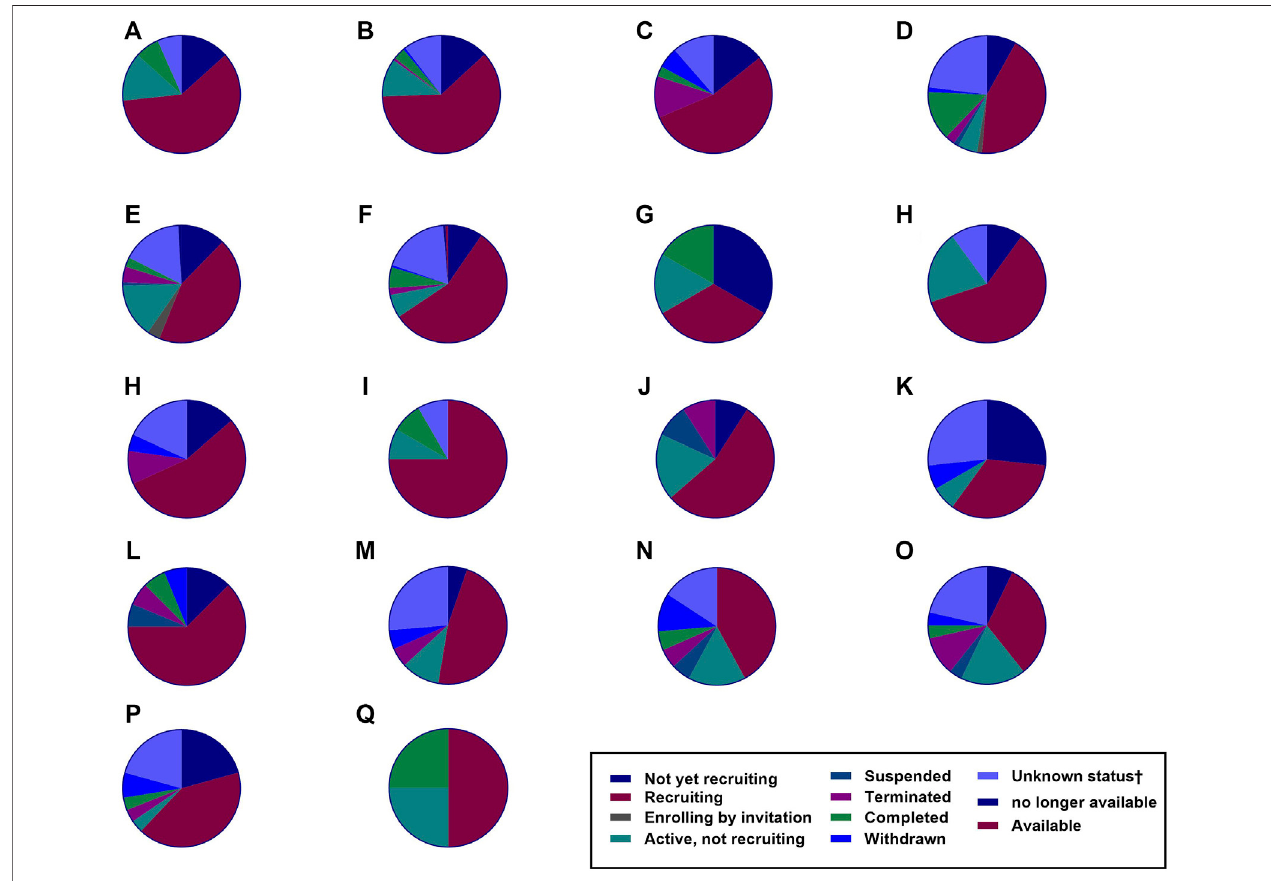
FIGURE 5 | The number ofclinical trials. Several clinical trials have been investigating various malignancies as recorded by ClinicalTrials.gov. Based on the data up toJanuary2022,thenumberoftheseclinicaltrialsisrising.The fi gureshowsthenumberofCART-celltherapyclinicaltrialsforhematologicalmalignancies,solidtumors, and HIV infection (total = 789). (A) Hodgkin ’ s lymphoma = 15 studies. (B) Acute myeloid leukemia = 35 studies. (C) Chronic lymphocytic leukemia = 74 studies. (D) Multiplemyeloma=114studies. (E) Non-Hodgkin ’ slymphoma=153studies. (F) Acutelymphoblasticleukemia=157studies. (G) HumanImmunode fi ciencyVirus = 6studies. (H) Prostate Cancer= 10studies. (I) Brain Cancer= 12studies. (J) RenalCancer =12studies. (K) Colorectal Cancer= 15studies. (L) Ovarian Cancer =16 studies. (M) Lung Cancer = 22 studies. (N) Gastric Cancer = 19 studies. (O) Breast Cancer = 19 studies. (P) Pancreatic Cancer = 28 studies. (Q) Liver Cancer = 29 studies. (R) Malignant pleural mesothelioma = 4